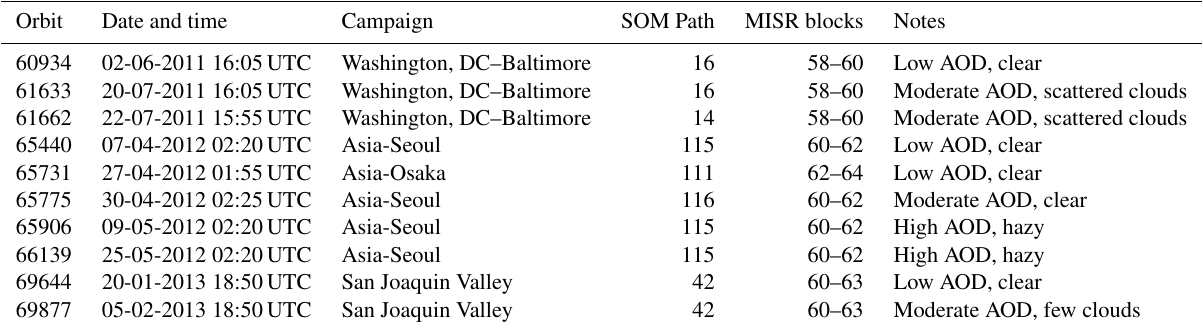
Table 2. MISR cases for AERONET-DRAGON